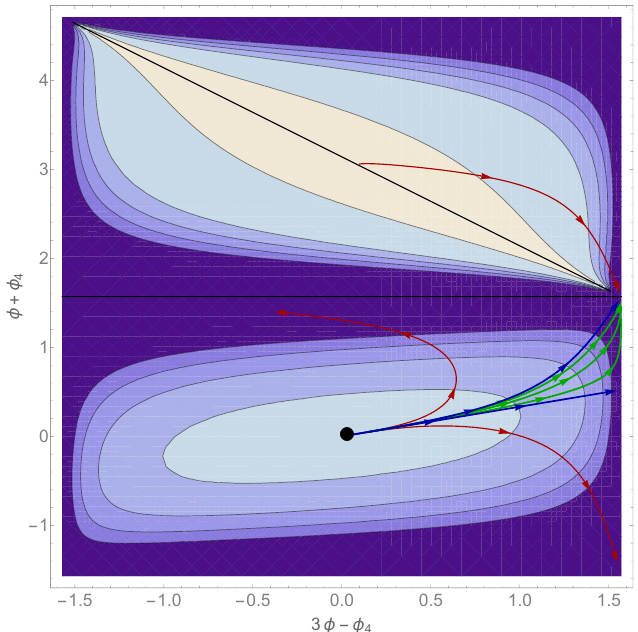
Figure 1 . Contour plot of e K WW as a function of the scalars (cid:30) and (cid:30) 4 on the surface (cid:11) = 0. We restrict the plot to the fundamental domain of the two scalars. The AdS 5 solution has vanishing scalar (cid:12)elds and corresponds to the solid dot. The coloured curves represent BPS domain wall (cid:13)ows with non-trivial scalars projected onto the ( (cid:30); (cid:30) 4 ) plane. The two blue lines correspond to GPPZ (cid:13)ows with (cid:21) = (cid:6) 1, the GPPZ (cid:13)ows with (cid:0) 1 < (cid:21) < 1 all lie in between the two blue curves and are represented by the green curves. The two red lines denote unphysical domain wall (cid:13)ows according to the Gubser criterion which asymptote to the UV AdS 5 region. The red line in the upper half of the domain corresponds to an acceptable singular (cid:13)ow which does not connect to the AdS 5 solution. The Coulomb branch solution with (cid:30) = (cid:30) 4 = 0 is not visible on the plot since it starts from AdS 5 and extends in the direction orthogonal to the ( (cid:30); (cid:30) 4 )